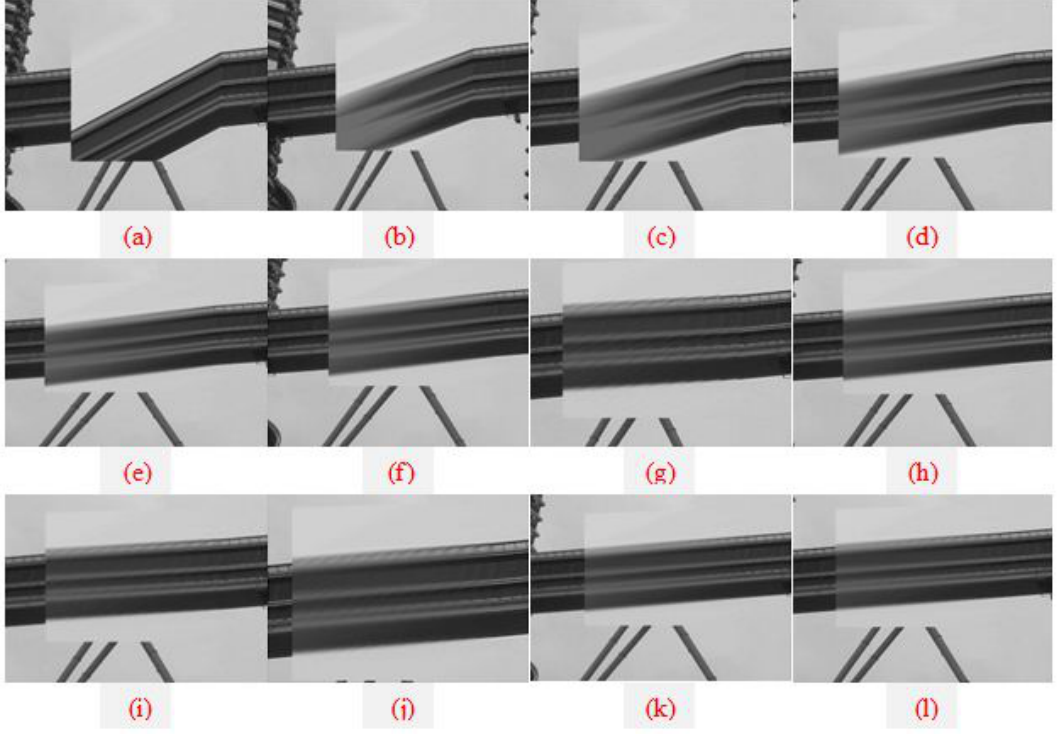
Fig. 6. Steps to recovering damaged blocks: (a) The interpolation process between the first upper row and the first column to the right of the damaged block, (b, c, d, e, f, g, h, I, j, k, and l are with the 2 nd , 3 rd , 4 th , 5 th , 10 th , 12 th , 14 th , 16 th , 184 th , 20 th and 22 nd columns, respectively.